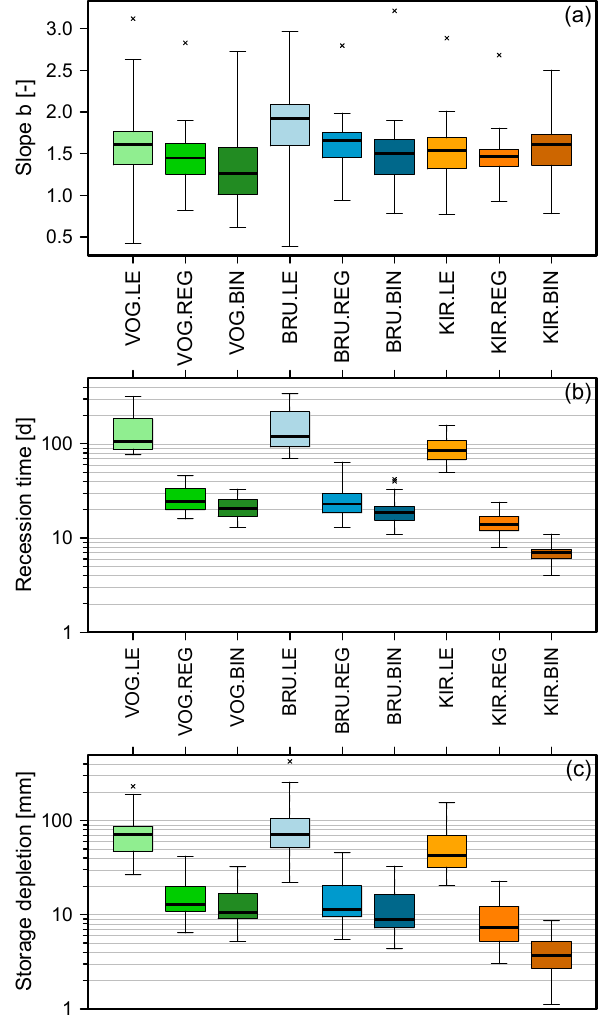
Fig. 3. Distributions of slope b (a) , recession time T R (b) and stor- age depletion S R (c) for the study catchments grouped by RAMs. The colored boxplots span the interquartile range; the whiskers ex- tend according to the R -manual for the boxplot()- function to the most extreme data point, which is no more than three times the in- terquartile range from the box. Points that lie outside this range are marked as outlier